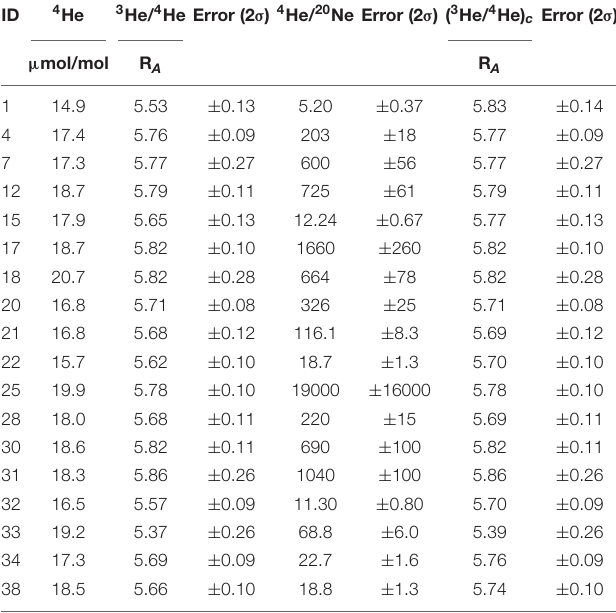
different approach in calculating the He concentration yields a much lower value ( Table 3 ). This suggests that this difference may result from an analytical problem during gas chromatography.